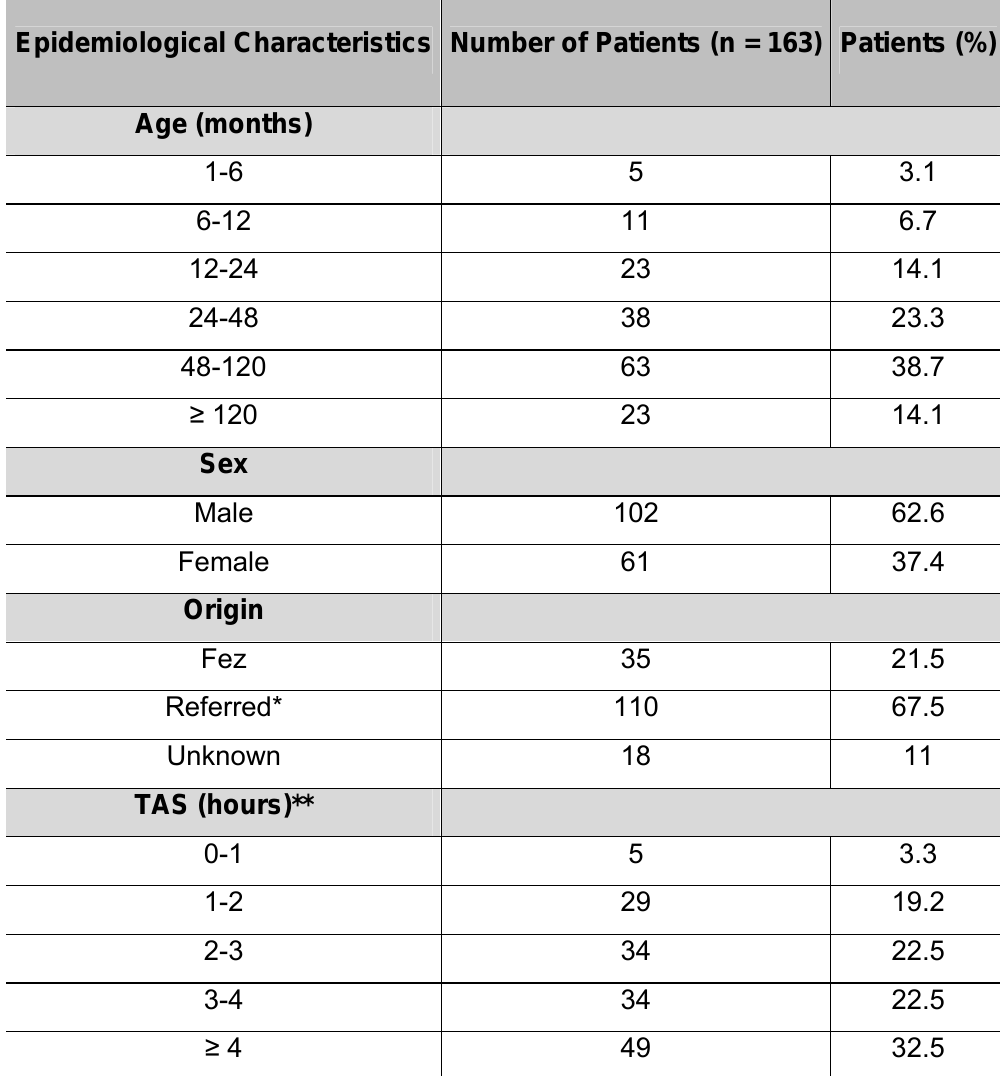
Table1. Epidemiological characteristics of children stung by scorpions Epidemiological Characteristics Number of Patients (n = 163) Patients